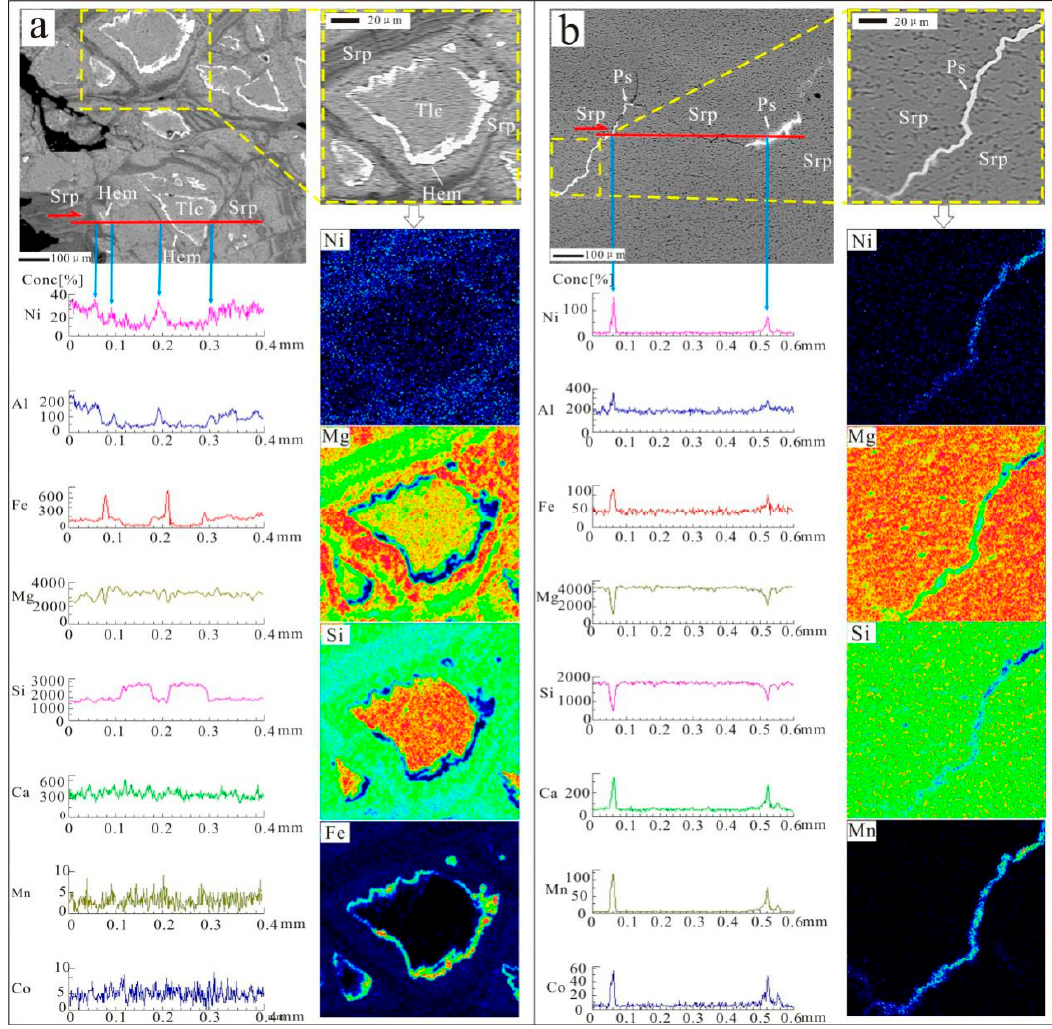
Figure 8. Element lines and mappings in some selected micro areas from the silicate ore at the saprolite: ( a ) elemental distribution in an aggregate of residual serpentines with different morphology; and ( b ) elemental distribution in a manganeferous “wad” appearing in a micro area.